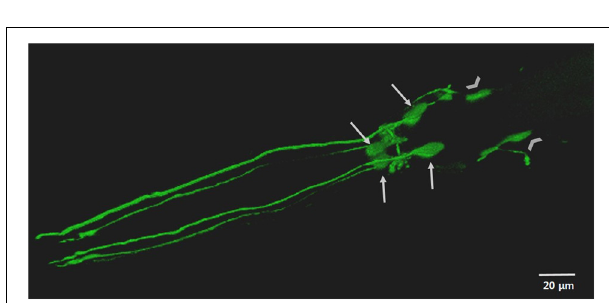
two anterior deirid (ADE) neurons, and two posterior deirid (PDE) neurons. Males have six additional DAergic neurons located in the tail (not shown).